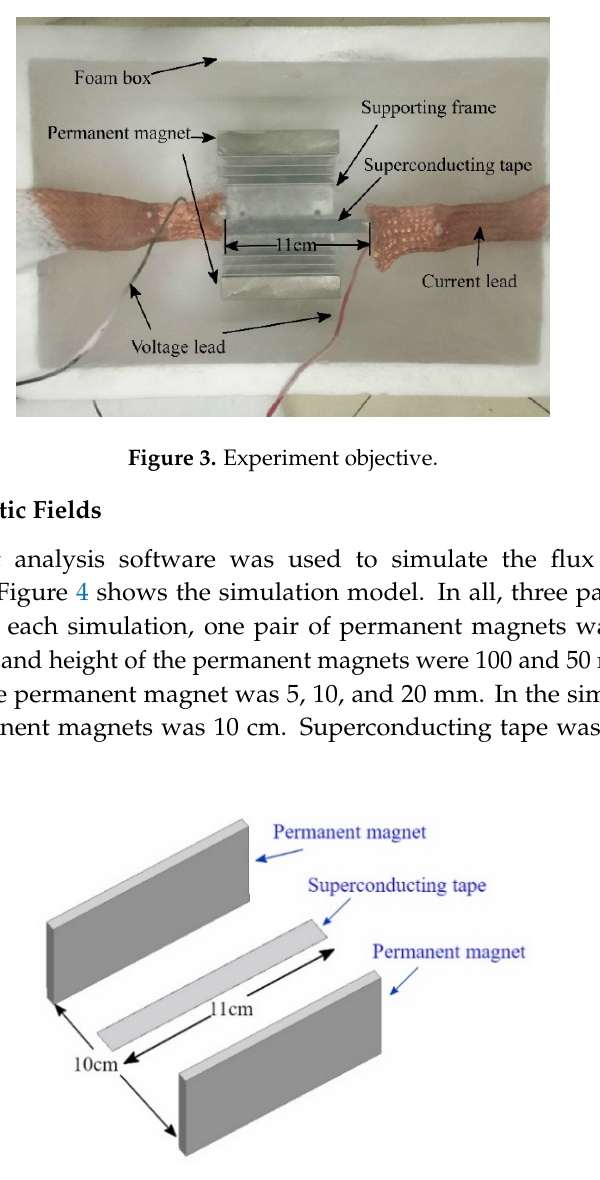
Figure 4. The simulation model of the experiment objective.